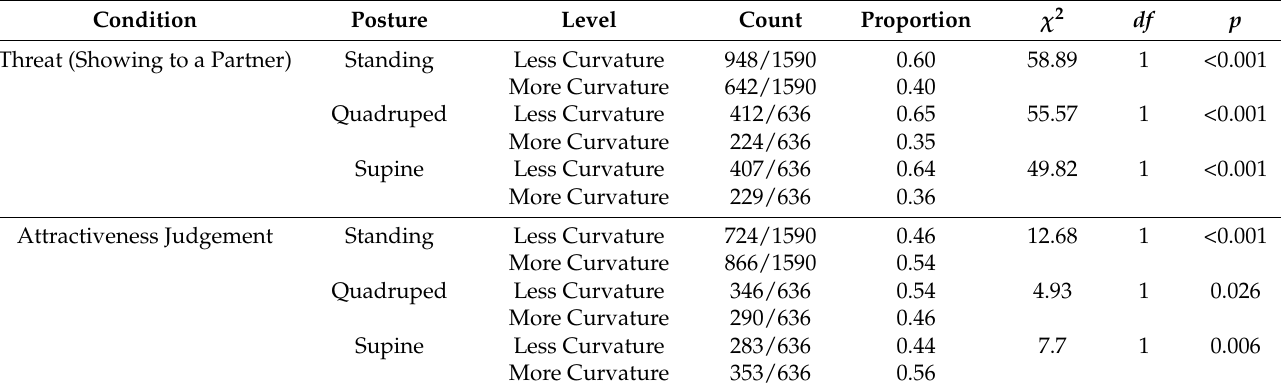
Table 1. Chi-squared goodness-of-fit proportion test for probability of threat and attractiveness judgements of female stimuli in the standing, quadruped, and supine postures by women as a function of lumbar